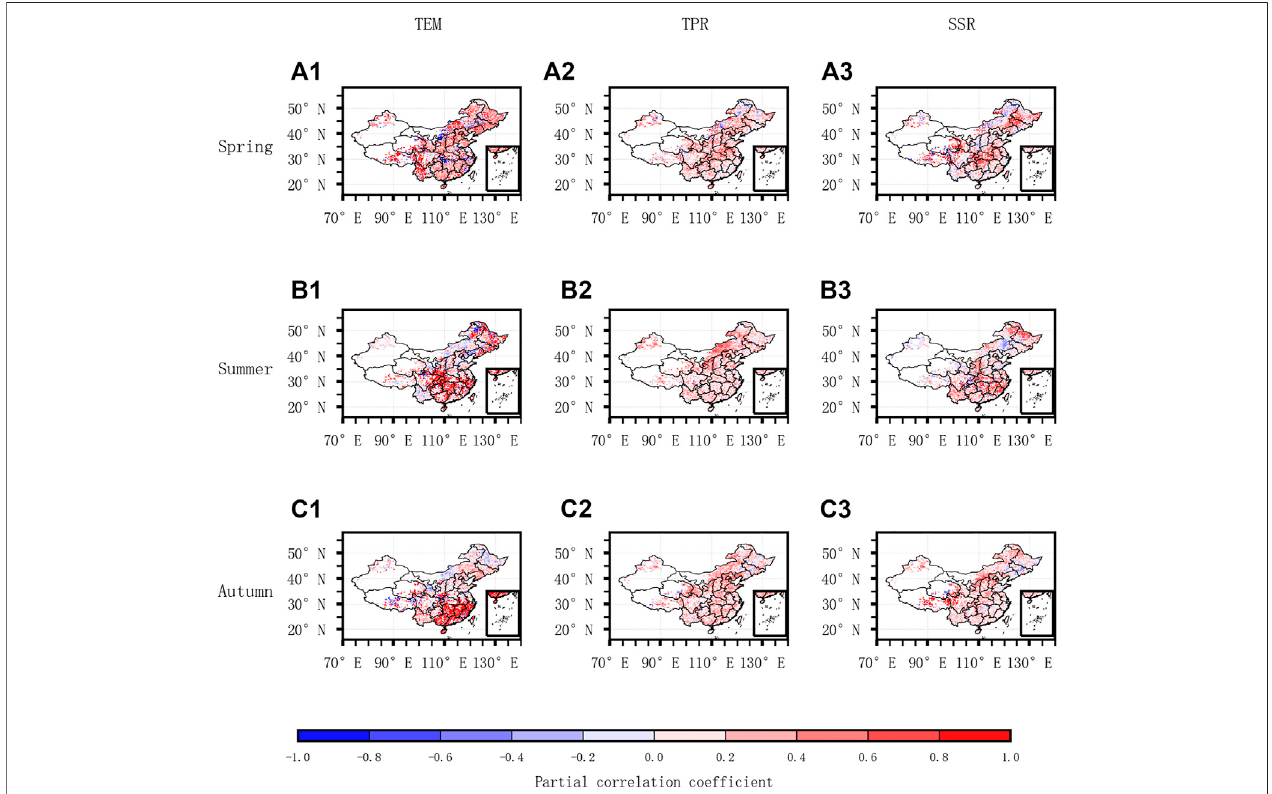
FIGURE 3 | Partial correlation coef fi cient between vegetation coverage and meteorological elements (TEM, TPR, and SSR) in different seasons (spring, summer, and autumn), the absolute value of the partial correlation coef fi cient ≥ 0.455; it passes the 95 % signi fi cance test.